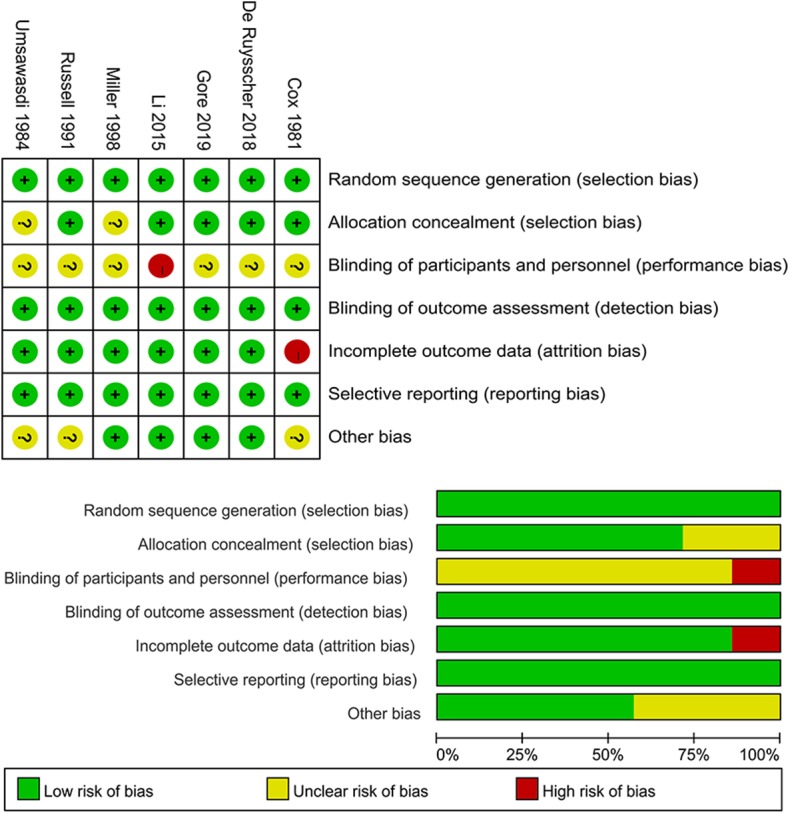
Methodological quality assessment of the included randomized controlled trials (upper: risk of bias graph; low: risk of bias summary).